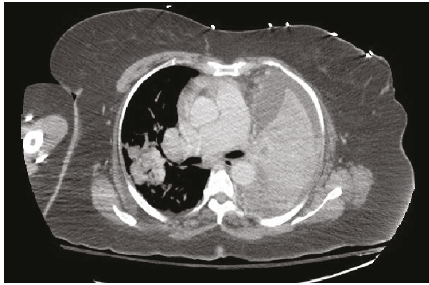
Figure 3: Extensive consolidation of the left lung with moderate to large pleural e ff usion and worsening consolidation of the right